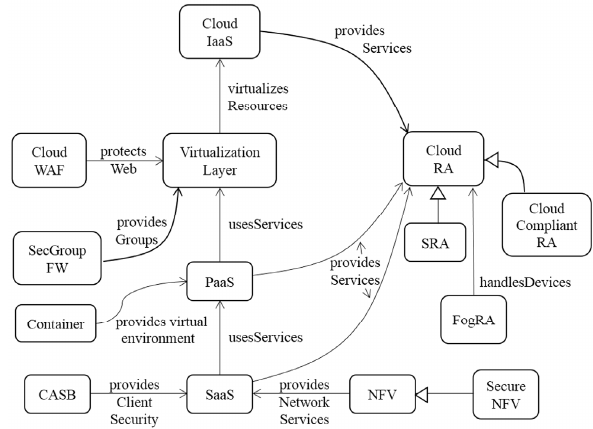
Figure 1. A cloud ecosystem (showing its latest additions).